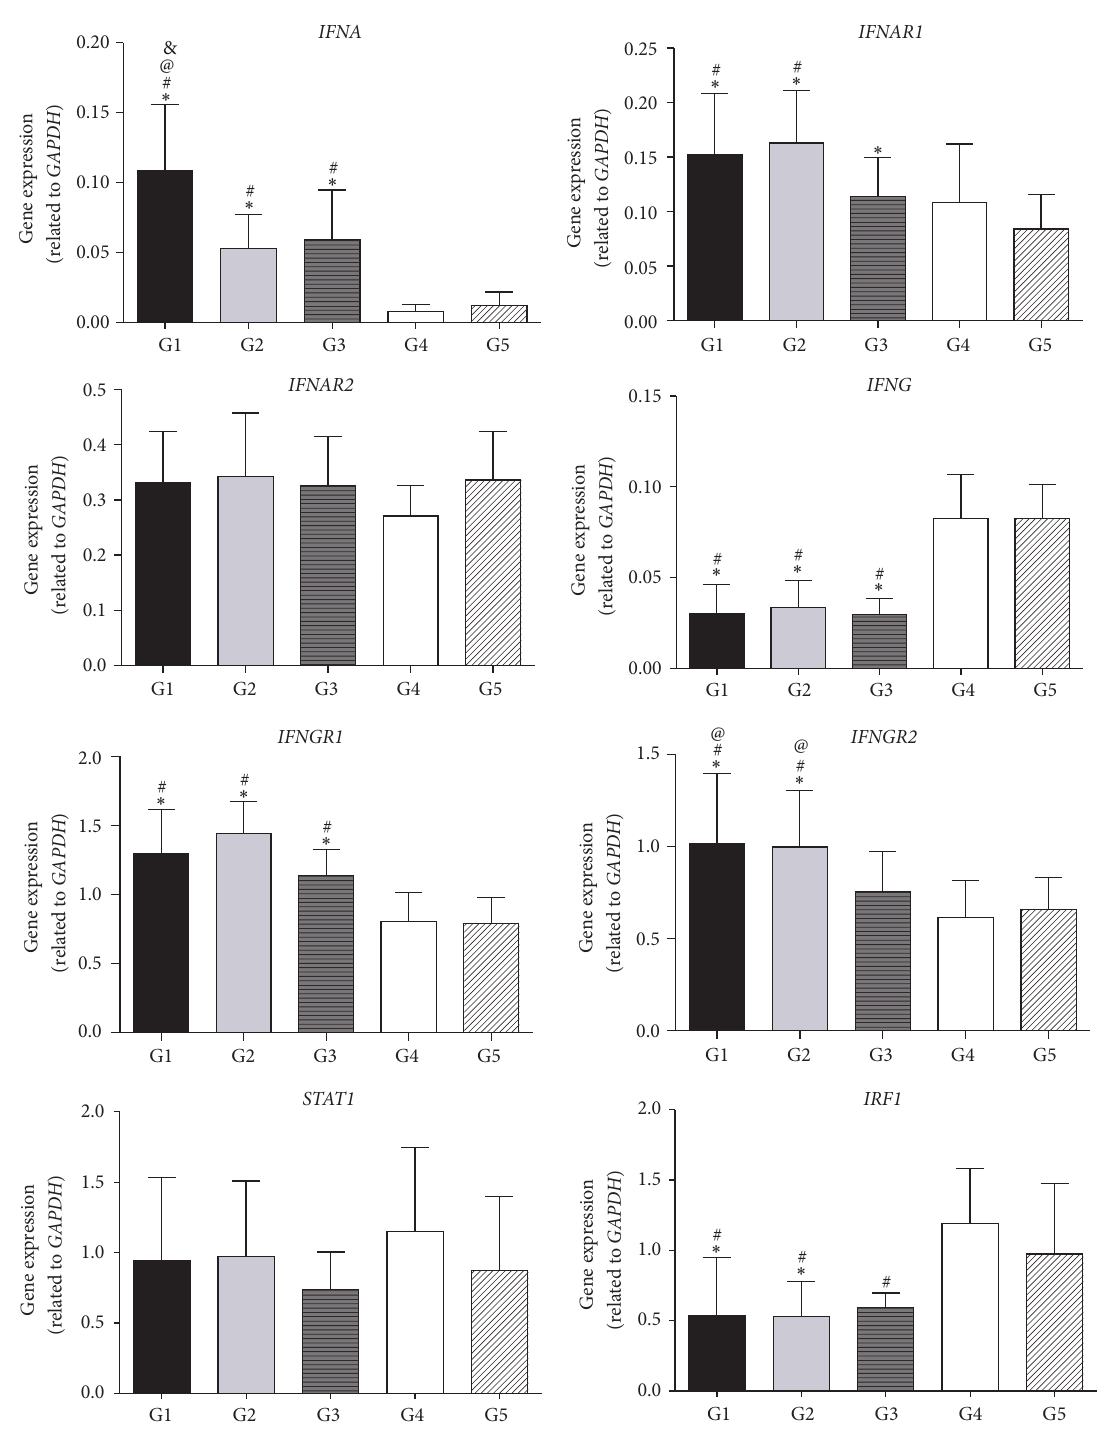
Figure 2: Signaling pathway of IFNA and IFNG genes in groups G1, G2, G3, G4, and G5. All values were normalized to GAPDH . Data represent the mean ± SD. & 𝑃 ≤ 0.05 compared to G2; @ 𝑃 ≤ 0.05 compared to G3; # 𝑃 ≤ 0.05 compared to G4; ∗ 𝑃 ≤ 0.05 compared to G5. Comparisons between all groups were performed by the Kruskal–Wallis test, and Dunn test was used to correct for multiple